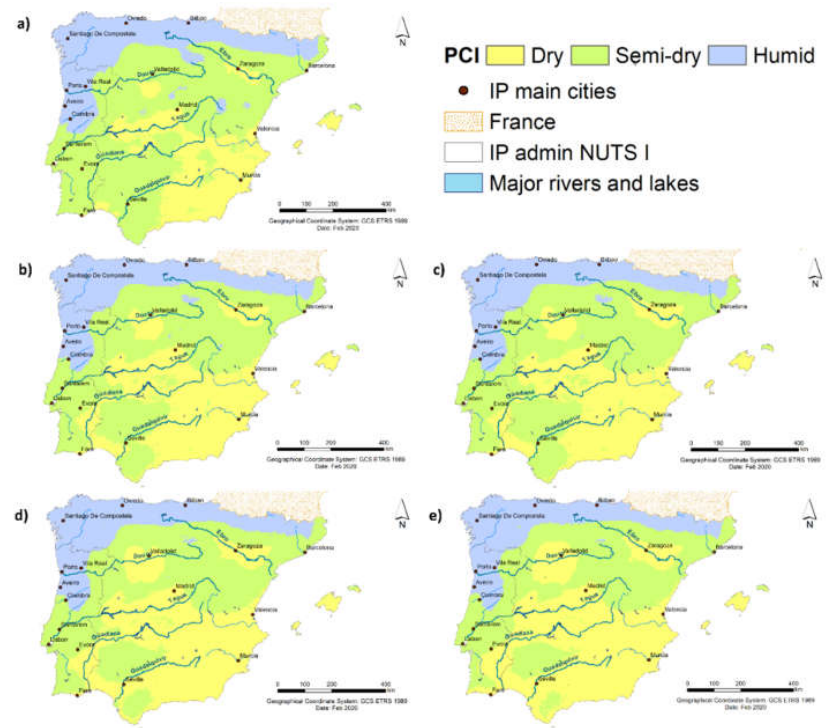
Figure 6. The Pinna Combinative Index (PCI) spatial distribution for the Iberian Peninsula for the period ( a ) 1961 1990, ( b , c ) 2011 2040, and ( d , e ) 2041 2070 under RCP4.5 ( left ) and RCP8.5 ( right ) scenarios.